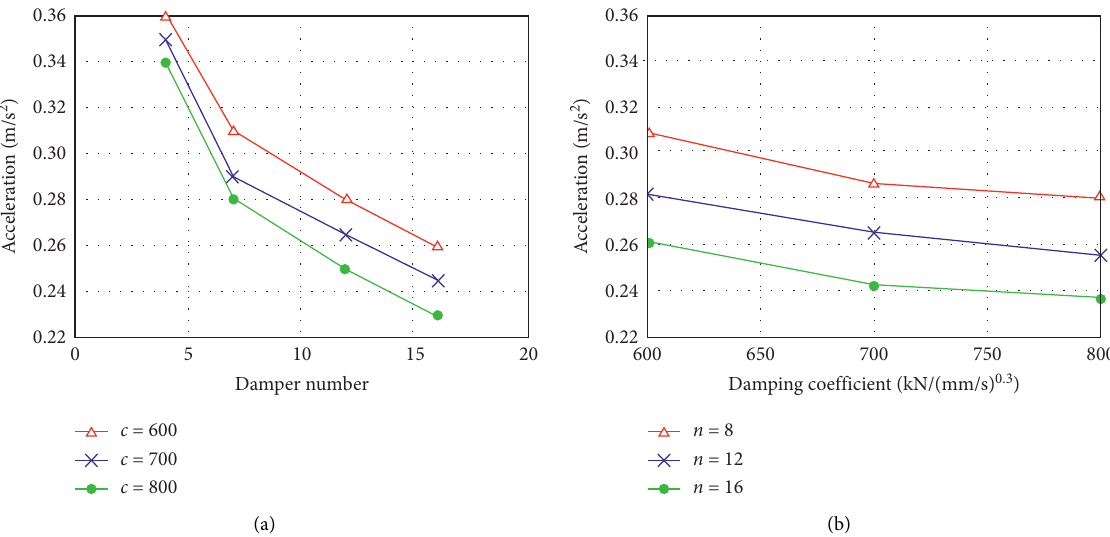
Figure 15: Characteristic of the controlling effect of the damped outrigger. (a) Damper number-peak acceleration curve. (b) Damping coefficient-peak acceleration